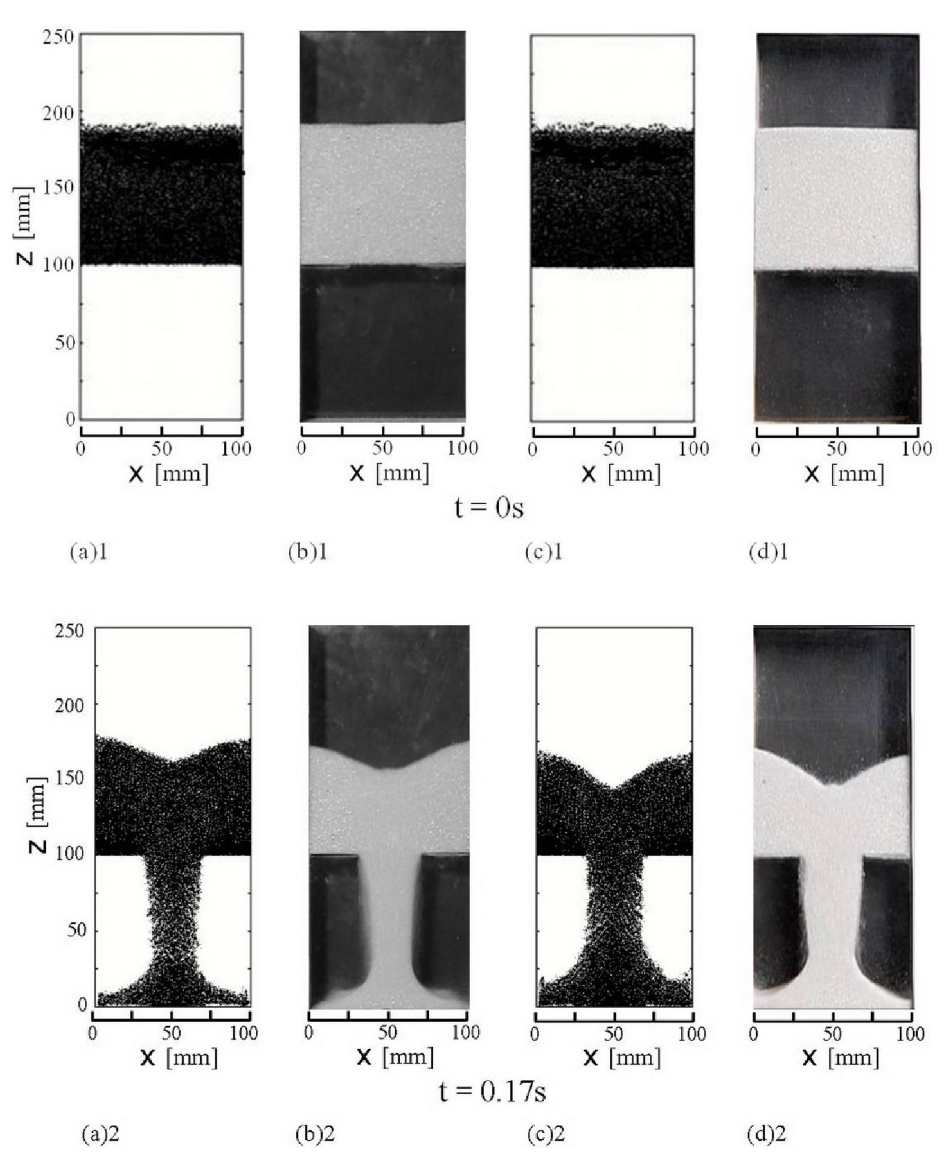
Figure 4. Calculated and experimental snapshots of granular flow in the flat-bottomed hopper and bin. (a)1, (a)2, (a)3, (a)4, (a)5, (a)6 and (a)7 Calculated results in the presence of air. (a’)2 Granular flow areas from the slit outlet to the top of the pile on the bottom of (a)2. (b)1, (b)2, (b)3, (b)4, (b)5, (b)6 and (b)7 Experimental results in the presence of air. (c)1, (c)2, (c)3, (c)4, (c)5, (c)6 and (c)7 Calculated results in a vacuum. (c’)2 Granular flow areas from the slit outlet to the top of the pile on the bottom of (c)2. (d)1, (d)2, (d)3, (d)4, (d)5, (d)6 and (d)7 Experimental results in the very low pressure (10Pa) air. The movie of these granular flows is available at the supplementary material of this